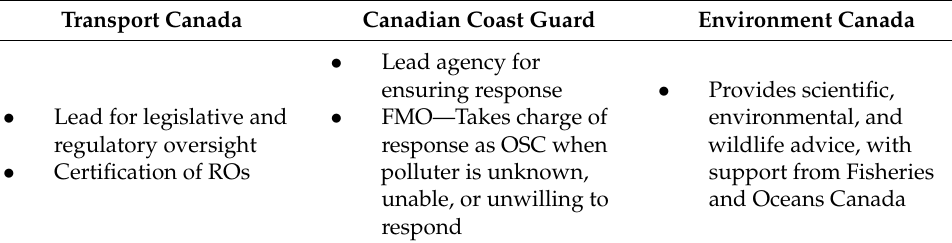
Table 2. Roles and Responsibility of Various Federal Agencies Marine Oil Spill